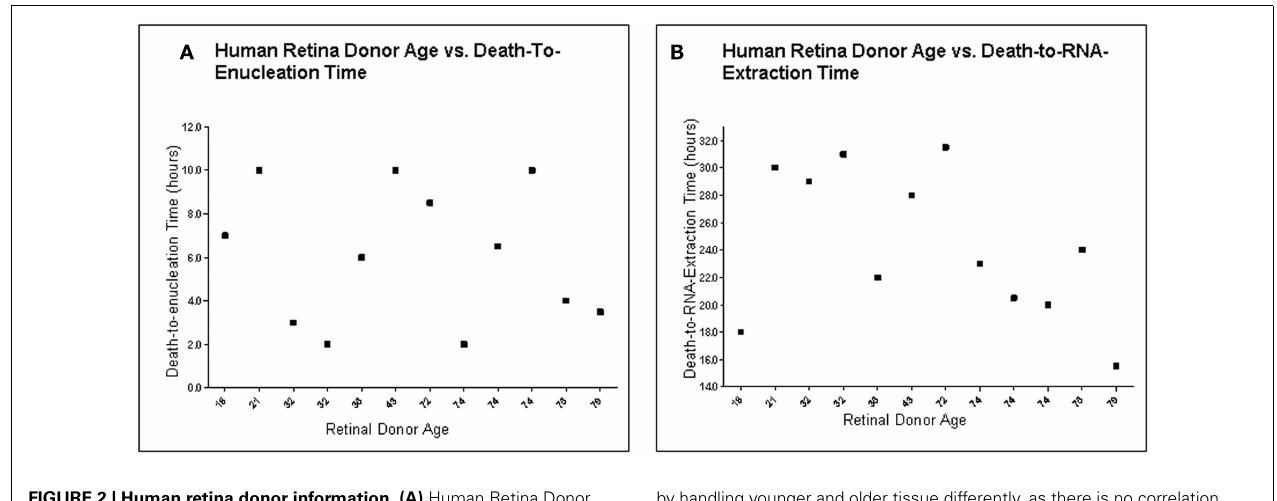
FIGURE 2 | Human retina donor information. (A) Human Retina Donor Age vs. Death-To-EnucleationTime (B) . Human Donor Age vs. Death-to-RNA-ExtractionTime. Data showed that no bias was introduced